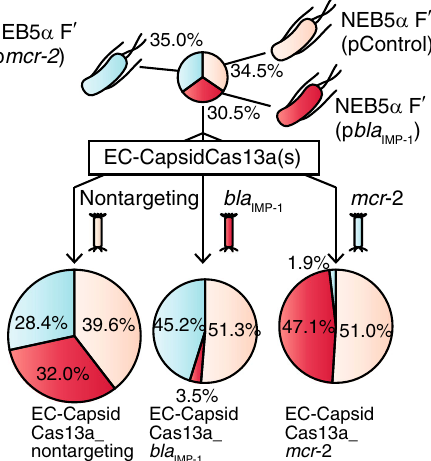
Fig. 3 Potential of CapsidCas13a as a tool for modifying bacterial fl ora. Programmed CapsidCas13a altered the composition of bacterial population. A mixed cell population was prepared by mixing E. coli NEB5 α F ′ I q (control) with equal numbers of NEB5 α F ′ I q expressing bla IMP-1 and mcr-2 , respectively. The cell mixtures were then independently treated with bla IMP-1 -targeting, mcr-2 - targeting, and nontargeting CapsidCas13a. Note that each AMR gene- targeting CapsidCas13a reduced the corresponding target cell population. The percentage represents the mean of three biological replicates. Source data are available in the Source Data fi le.